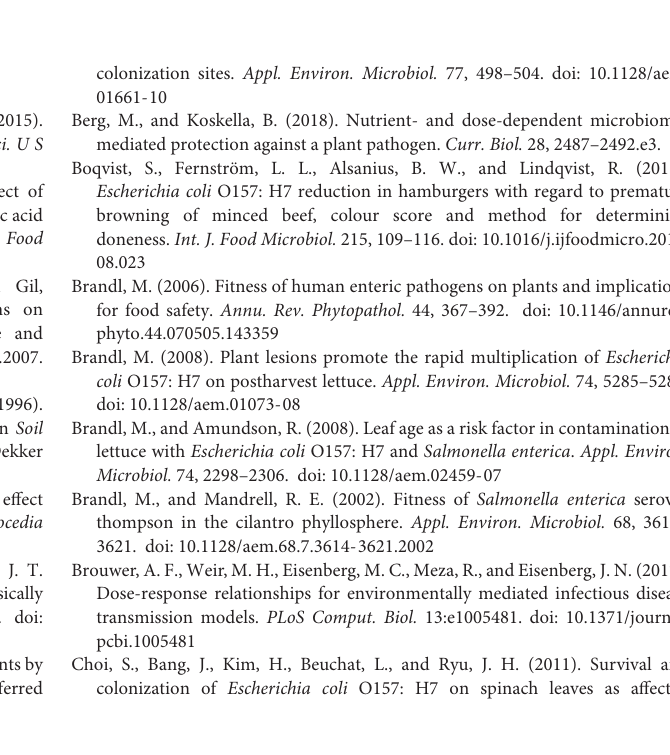
Supplementary Figure 7 | Colonization of tissue adjacent to lesions on artificially damaged spinach ( Spinacia oleracea L.) leaves by E. coli O157:H7 bacteria labeled with GFP. Leaves with a low ( A–C) , moderate (D–F) , and high (G–I) level of artificial damage were dip-inoculated with 10 6 CFU × mL − 1 E. coli O157:H7 and observed at 2 dpi. For images of undamaged leaves, see Supplementary Figure 5 A–C . Leaves were surface-sanitized with 0.25% sodium hypochlorite for